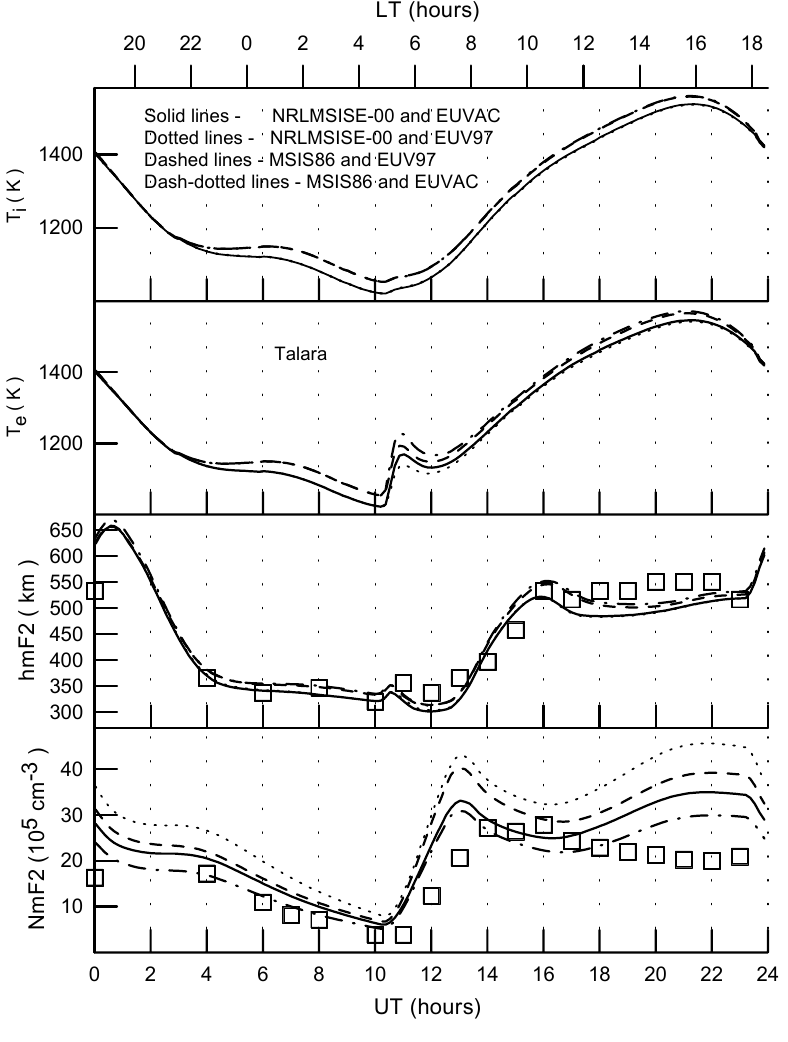
Solid lines - NRLMSISE-00 and EUVAC Dotted lines - NRLMSISE-00 and EUV97 Dashed lines - MSIS86 and EUV97 Dash-dotted lines - MSIS86 and EUVAC